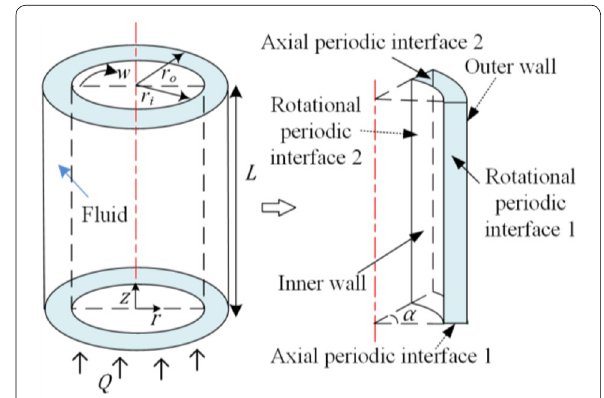
Figure 2 Schematics of TCP flow and the computational